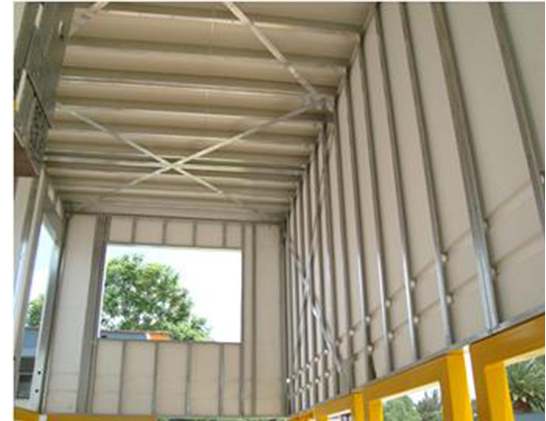
Figure 1. Interior view of the cold-formed steel